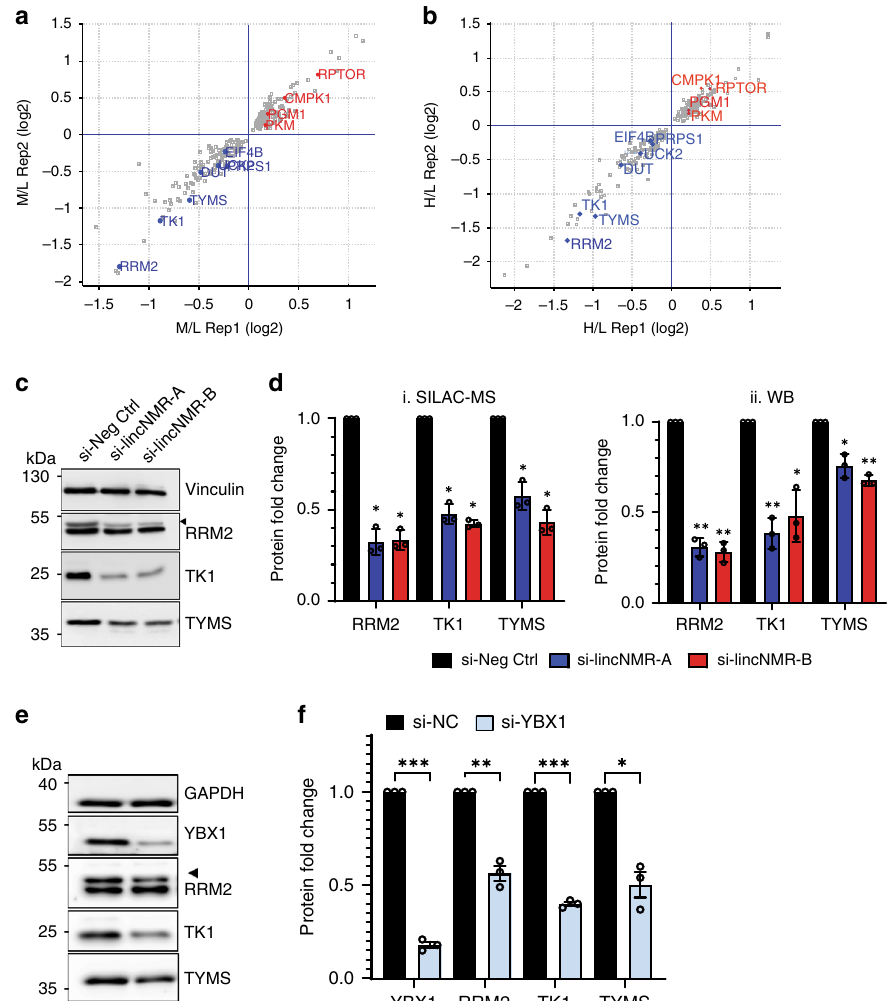
Fig. 4 lincNMR depletion downregulates key dNTP metabolism enzymes. a Triple-label SILAC-MS: scatter plot showing normalized M/L ratios representing deregulated proteins 48 h after lincNMR knockdown in replicates 1 and 2 with 10 nM siPOOLs in HLE cells (M/L = si-lincNMR-A/si-Neg Ctrl). b Triple-label SILAC-MS: scatter plot showing normalized H/L ratios representing deregulated proteins 48 h after lincNMR knockdown in replicates 1 and 2 with 10 nM siPOOLs in HLE cells (H/L = si-lincNMR-B/si-Neg Ctrl). c Western blot validation of SILAC-MS data depicting downregulation of RRM2, TK1, and TYMS proteins in HLE cells 72 h after lincNMR knockdown with 10 nM siPOOLs ( n = 3). Vinculin was used as a loading control. d Quantitative comparison of SILAC-MS (i) and western blot (ii) results con fi rming consistent downregulation of RRM2, TK1 and TYMS ( n = 3). log2 fold change was calculated and normalized to negative control siPOOL. e YBX1 silencing inhibits the expression of RRM2, TK1, and TYMS at 72 h post transfection with 10 nM siPOOL in HLE cells documented by western blotting ( n = 3). GAPDH was used as a loading control. f Quanti fi cation of western blot from ( e ): protein fold change was calculated by normalizing the RRM2, TK1, and TYMS signal to loading control GAPDH and to negative control siPOOL ( n = 3). a , b Data represent log2 fold change normalized to negative control siPOOL from two independent replicates. Highlighted proteins represent key deregulated players in purine and pyrimidine metabolism according to KEGG pathway annotations. Color key: red = upregulated proteins; blue = downregulated proteins. d , f Data represent mean, and error bars represent SEM. Signi fi cance was calculated by unpaired, two-tailed t test with * P < 0.05; ** P < 0.01; *** P <